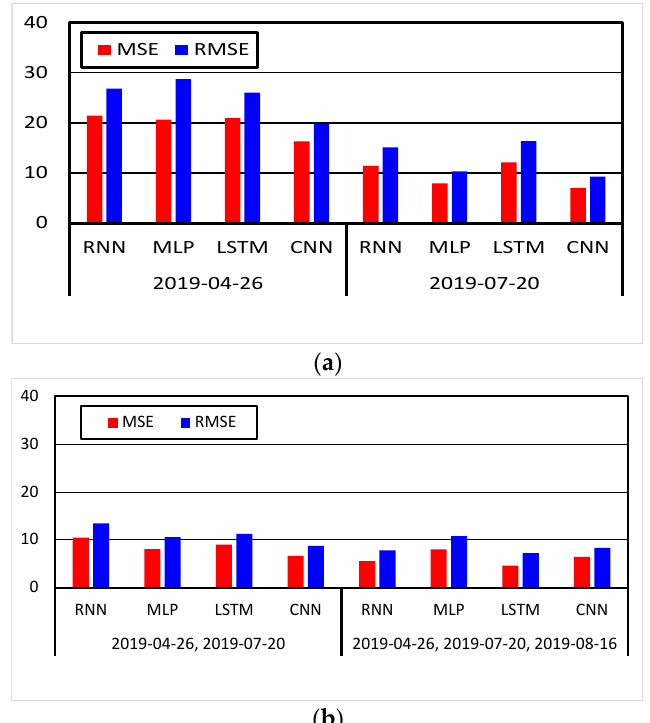
Figure 23. Training result errors for each algorithm as a function of the amount of data used for training: ( a ) prediction results after training with one day of data; ( b ) prediction results after training with two and three days of data.